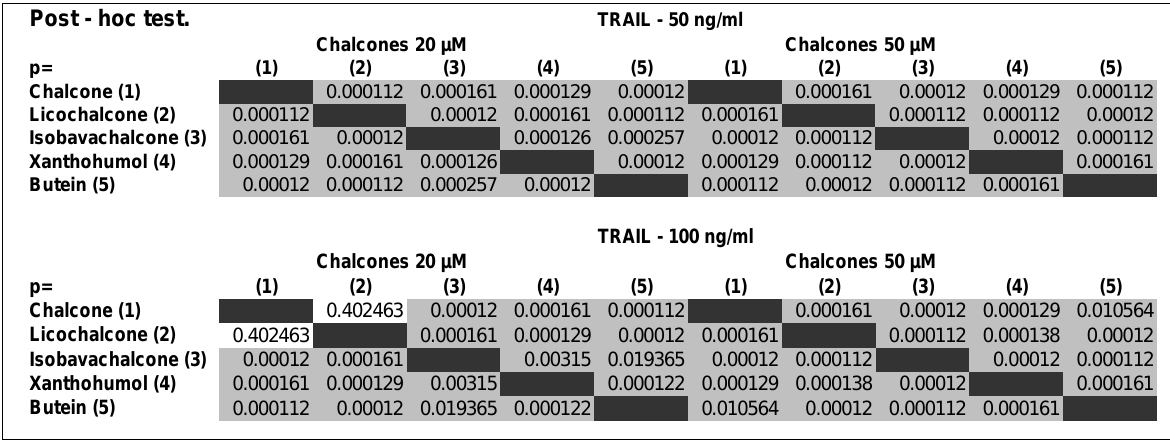
Table 2. Apoptosis induced by chalcones at concentrations 20 μ M and 50 μ M with TRAIL at concentrations 50 ng/mL and 100 ng/mL–p values. Post - hoc